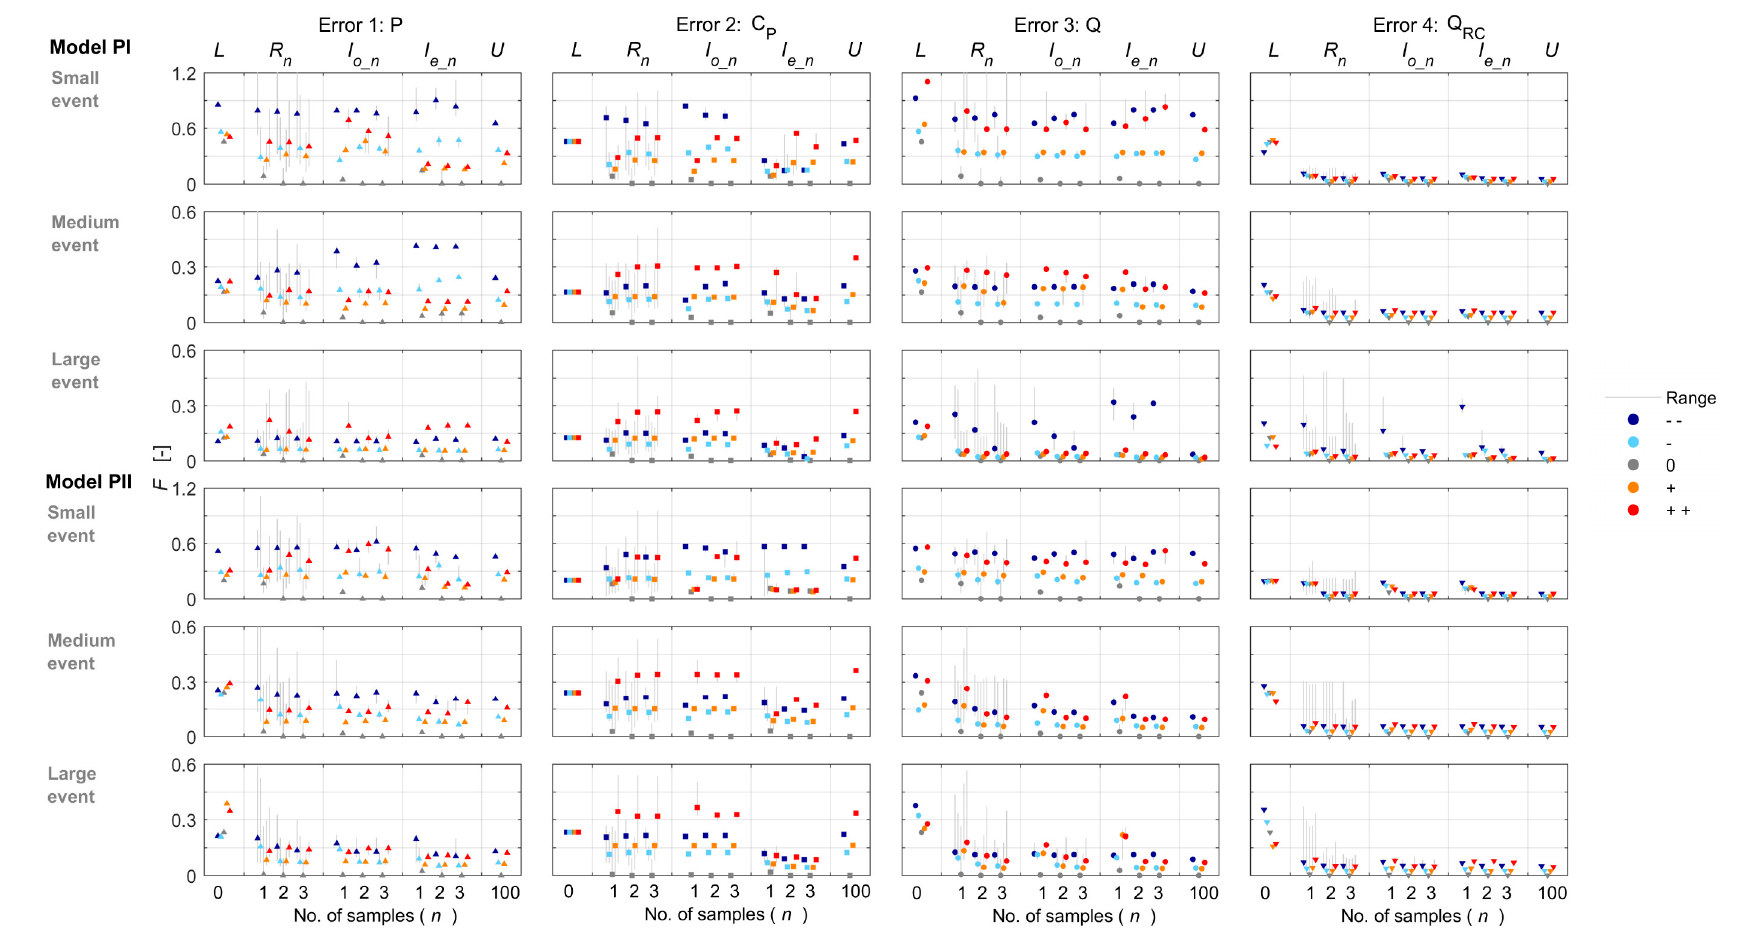
Figure 4. Effect of the inclusion of stream isotope information on model validation performance ( F ) for the different sampling strategies (lower benchmark ( L ), random selection ( R n ), two intelligent selections ( I 0_n and I e_n ) and upper benchmark ( U )), events and parameterizations (rows) and the different error types (columns). The symbols represent the median model performance and the grey lines the full range of F .